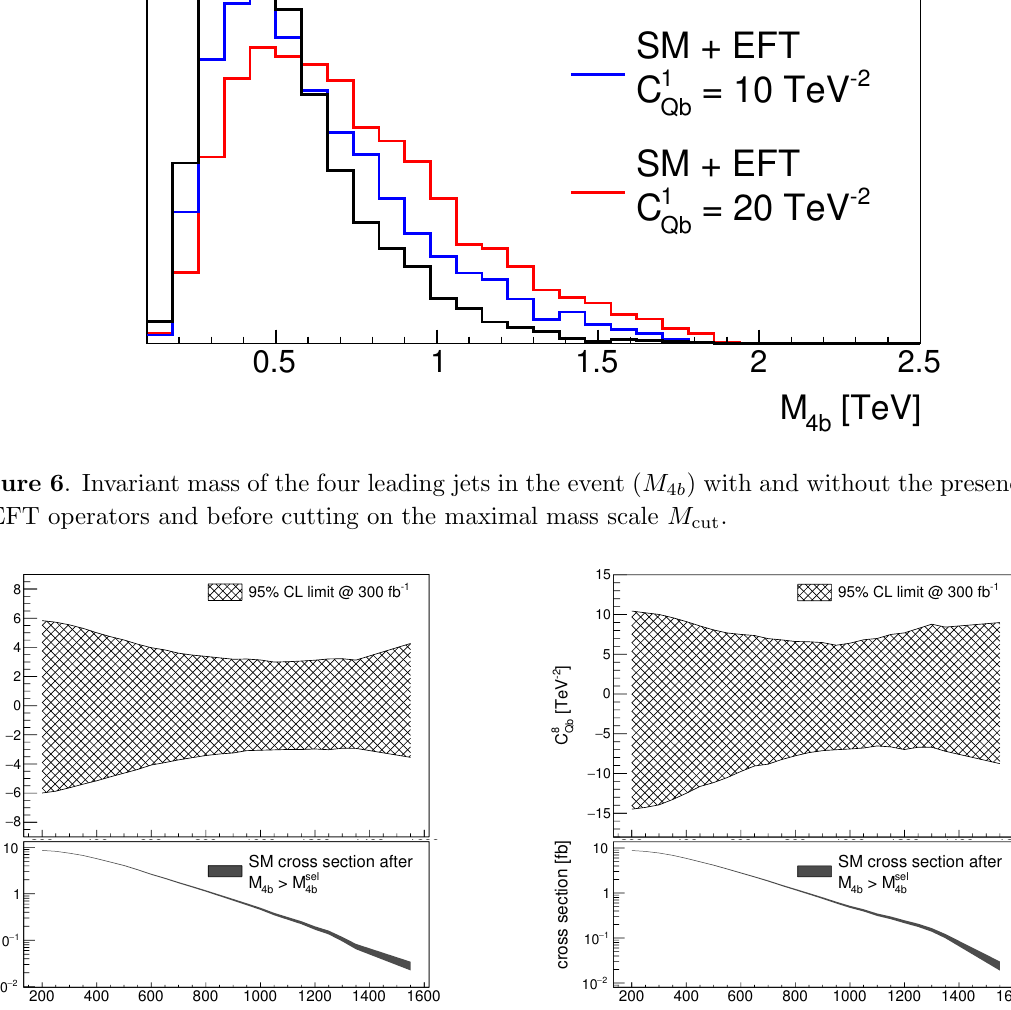
and C 8 as a function of the threshold on the Qb Qb ). In the bottom panel the predicted SM cross 4 b is shown, with the corresponding statistical uncertainty shown as a 4 b